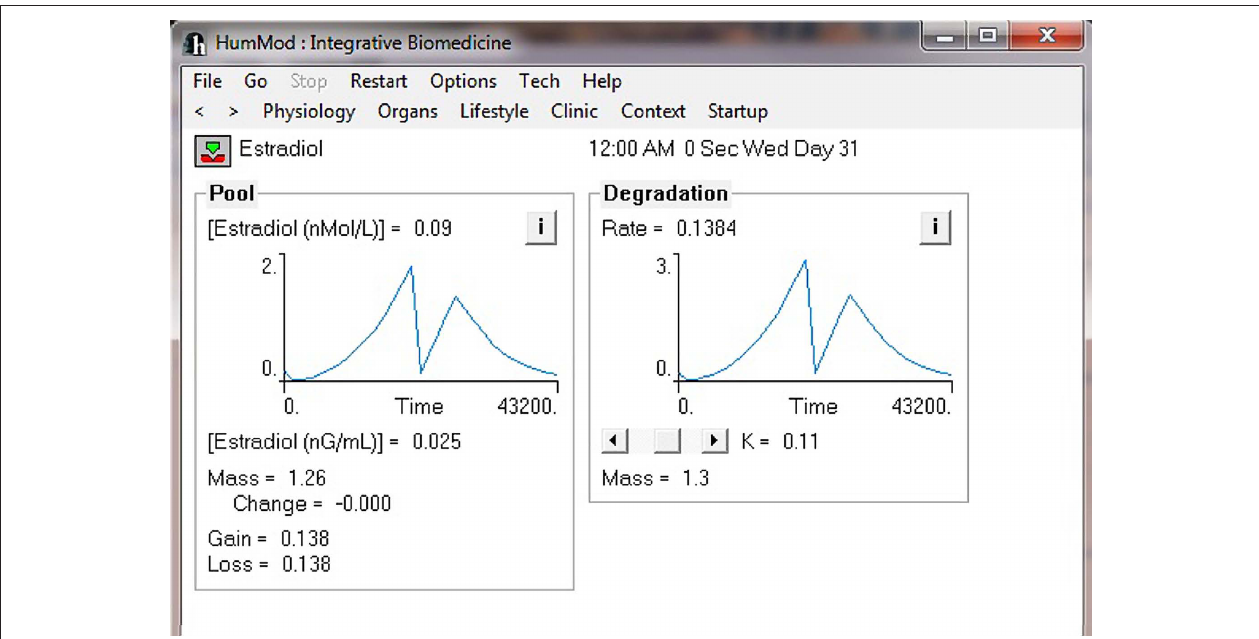
FigurE 8 | This figure demonstrates the ability of scaling in HumMod. The current version of HumMod has the ability to simulate female physiological function. Future scaling will include body composition